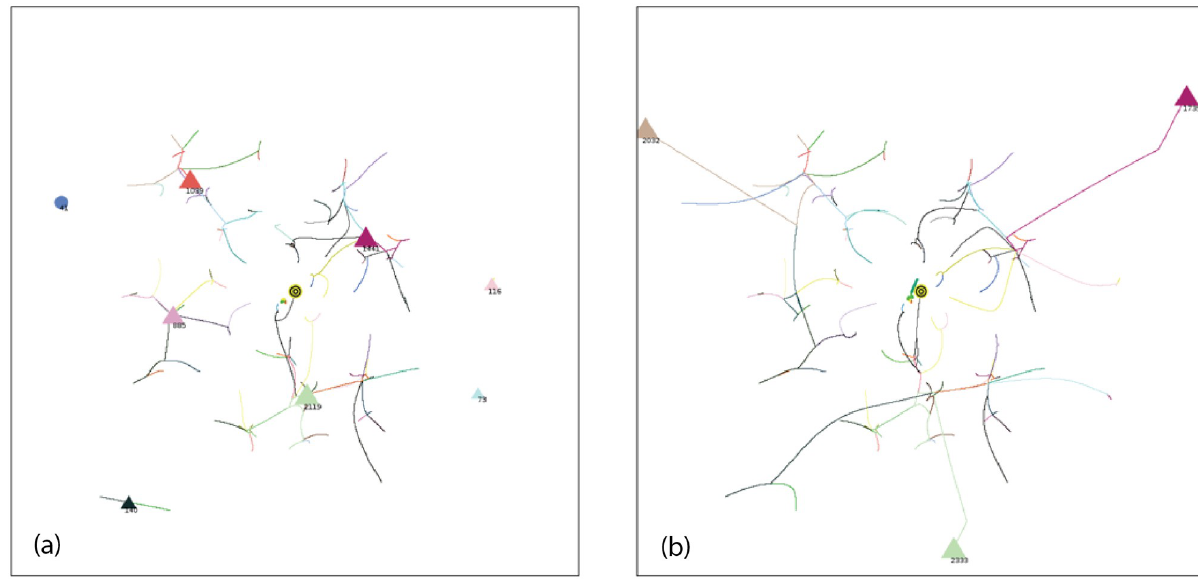
Fig 11. Simulation at 100% of completion. a) AIB = 30, ET = 6821, 7 groups, 1 individual, MDCN = 38, repulsive force < 0.8%, DT < 20. b) AIB = 180, ET = 54,030, 3 groups, MDCN = 181, repulsive force = 100%, DT � 140.